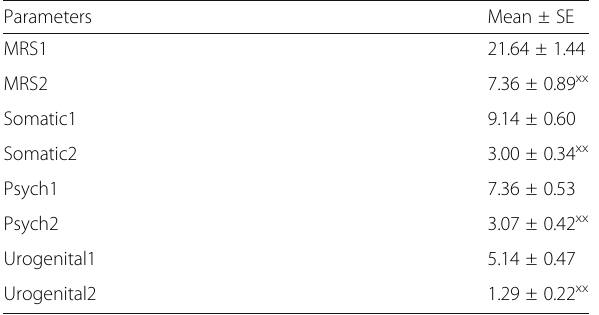
Table 5 Mean and p value of menopausal symptoms score before and after blend consumption